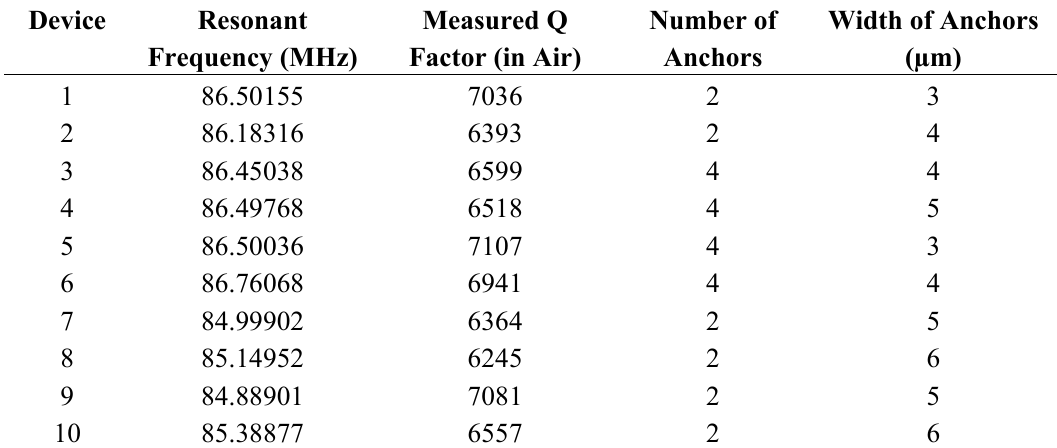
Table 3. Measured frequency characteristics of ten disk resonator devices operating at the fourth-order contour mode, which all have a 40 μ m radius, 20 μ m-thick silicon device layer and 5 μ m-long supporting anchors but different anchor numbers and